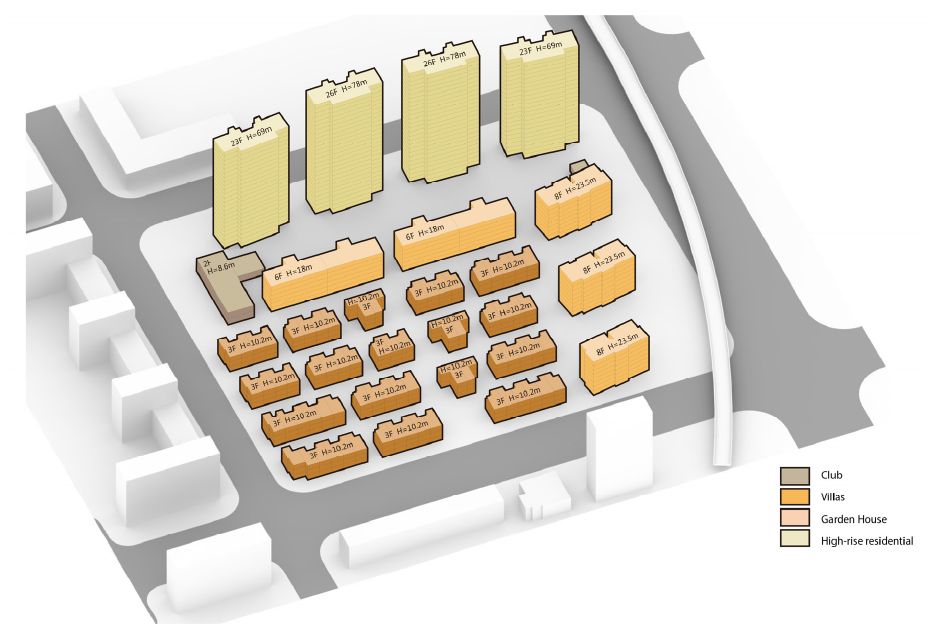
Figure 10. Distribution of residential types in Tianjin Tianbao Gold Coast Community.